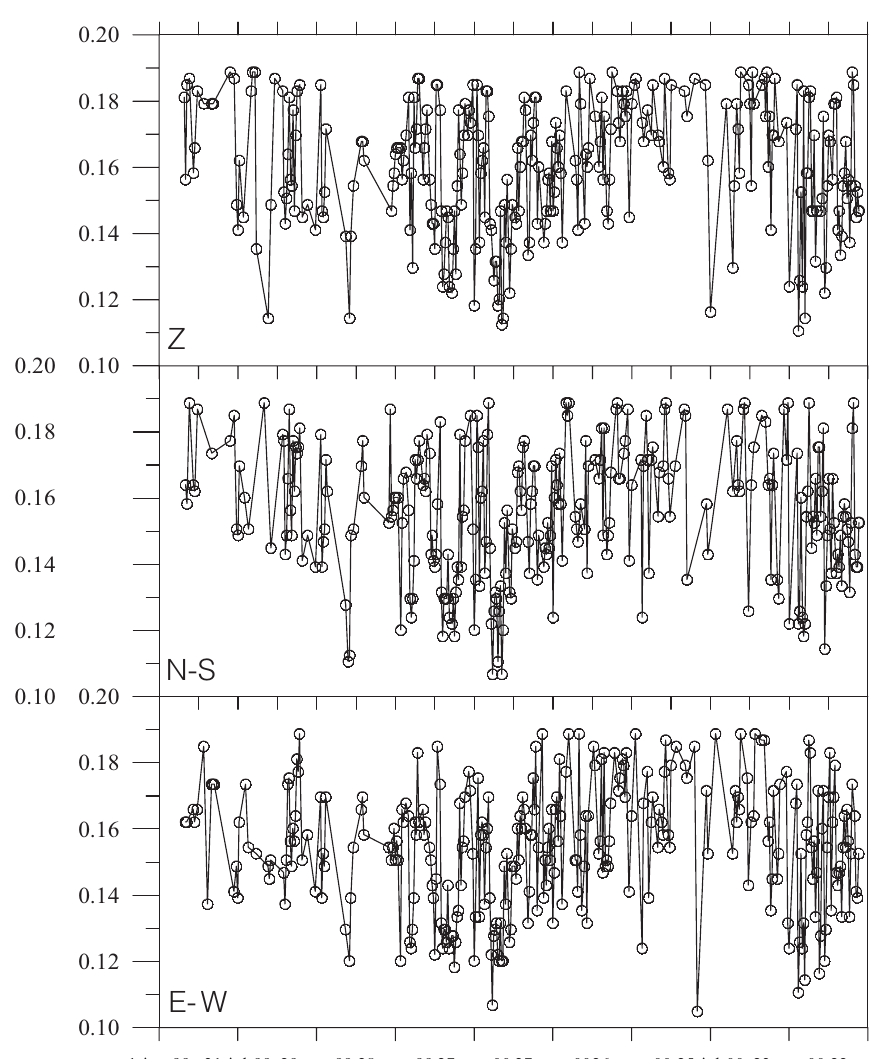
Fig. 9. Seasonal variation of the frequency for the three-component velocity power spectra peak of secondary